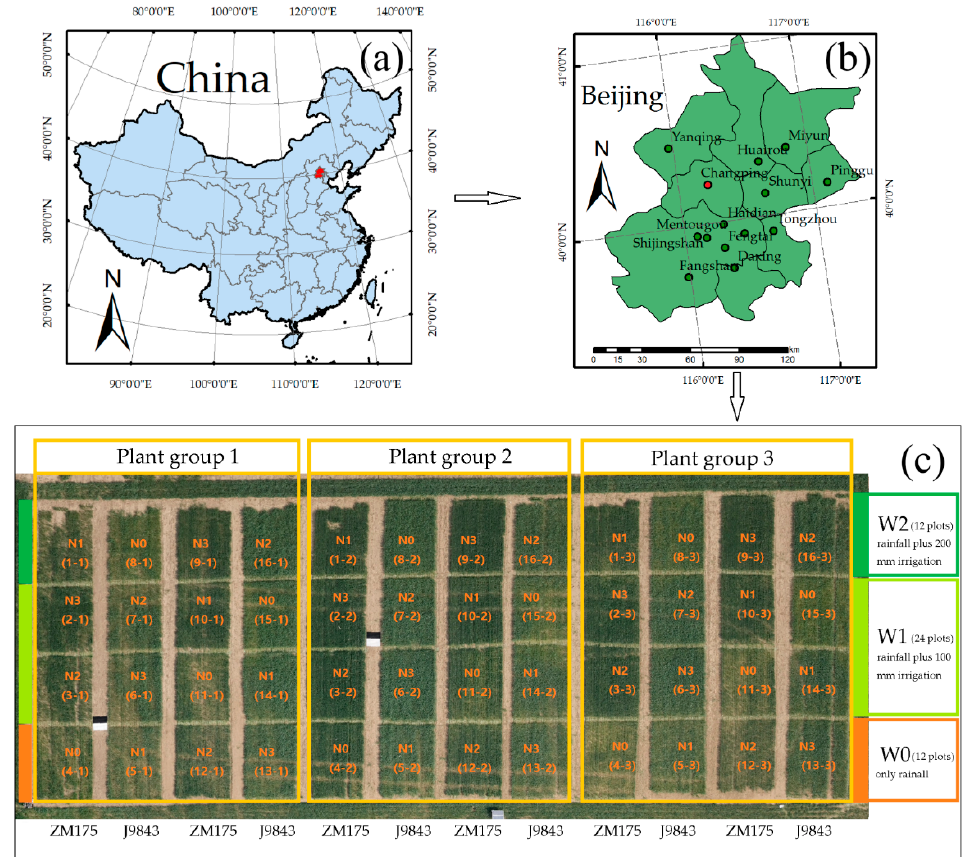
Figure 1. Location of study area and experimental design: ( a ) location of study area in China; ( b ) map showing Changping District in Beijing City; ( c ) design of treatments and images of ground-measurement field acquired from unmanned aerial vehicle mounted high-definition digital camera.